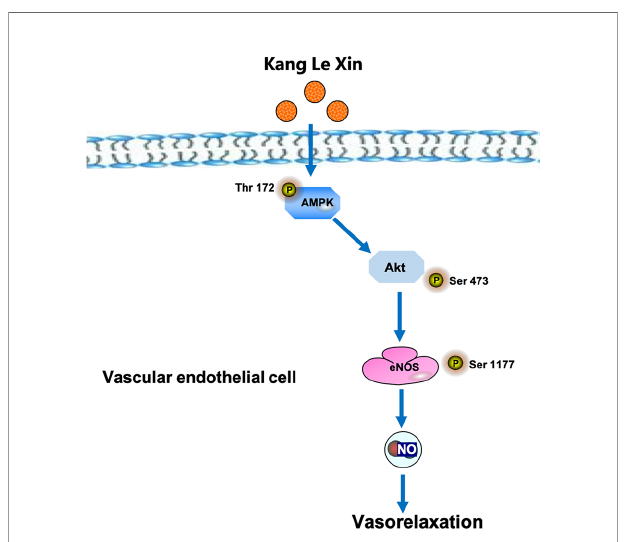
FIGURE 6 | Schematic diagram of the proposed signaling mechanisms by which KLX produces hypotensive